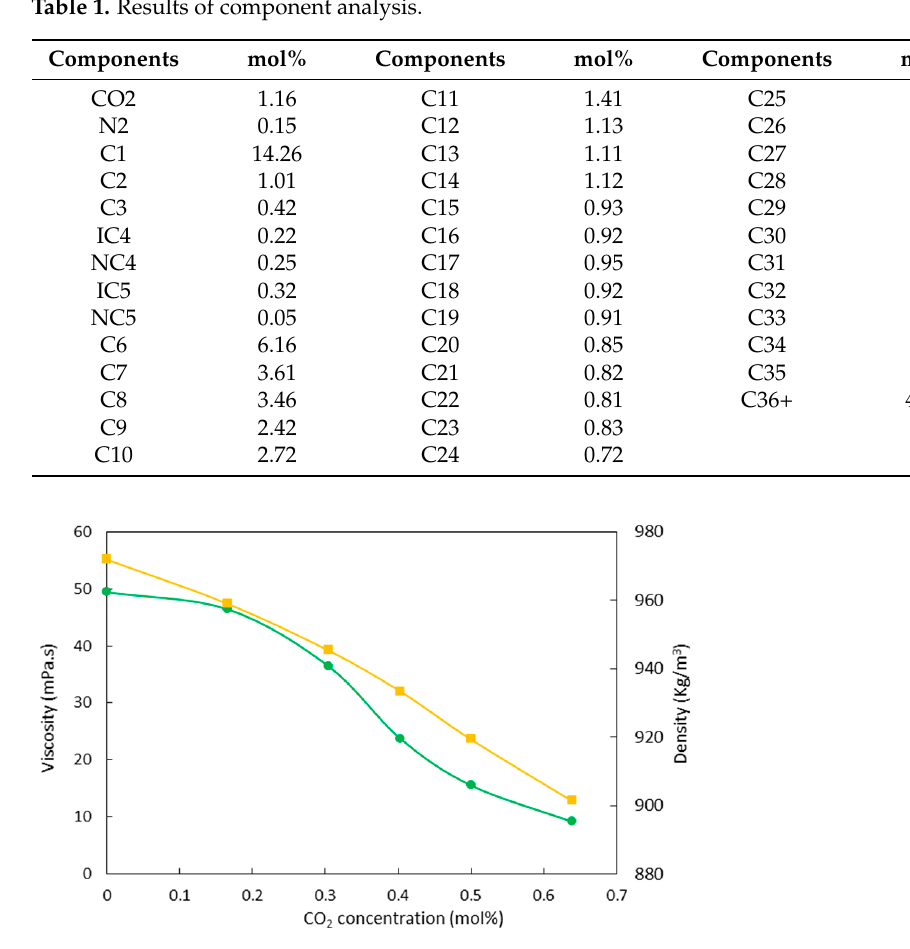
Table 1. Results of component analysis.